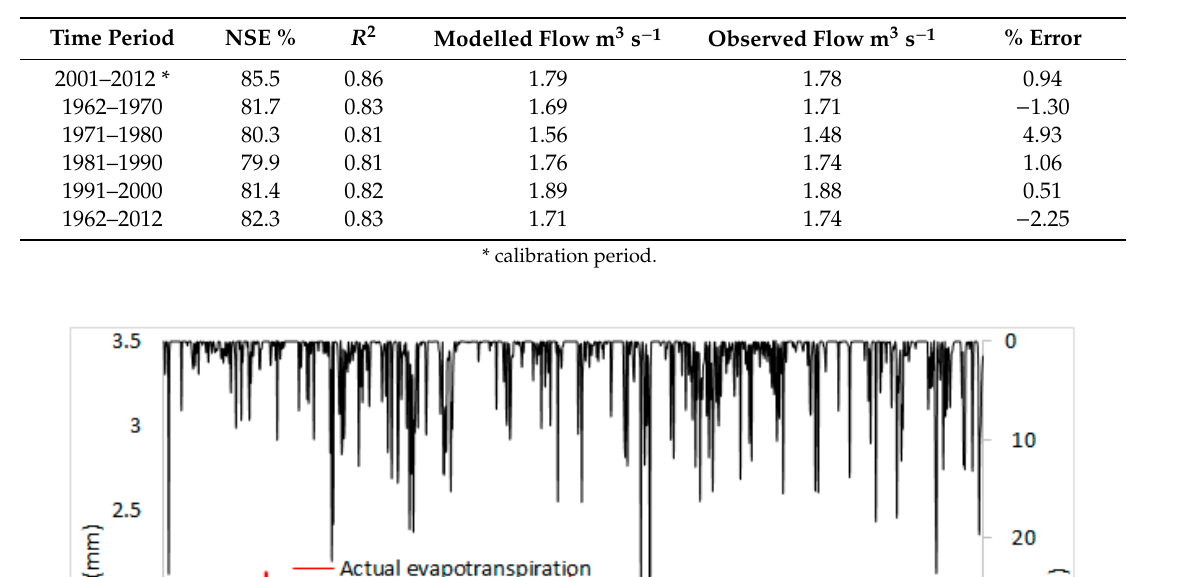
Figure 6. The actual evapotranspiration and net-rainfall for the Frome catchment during the drought period 1992–1994. Table 2. Model performance during the calibration and validation stages of the Frome streamflow.